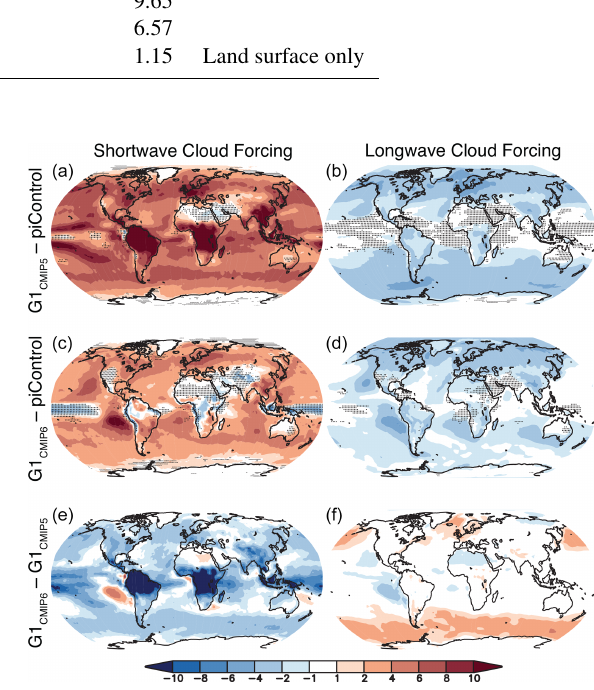
Figure 5. Surface shortwave (a, c, e) and longwave (b, d, f) cloud forcing (Wm − 2 ) change from pre-industrial values for the CMIP5 (a, b) and CMIP6 (c, d) ensembles, as well as the ensemble differences (e, f) . Cloud forcing is measured as all-sky minus clear- sky radiative flux. All shaded values are ensemble means. Lack of stippling indicates agreement on the sign of the values across at least 75% of the